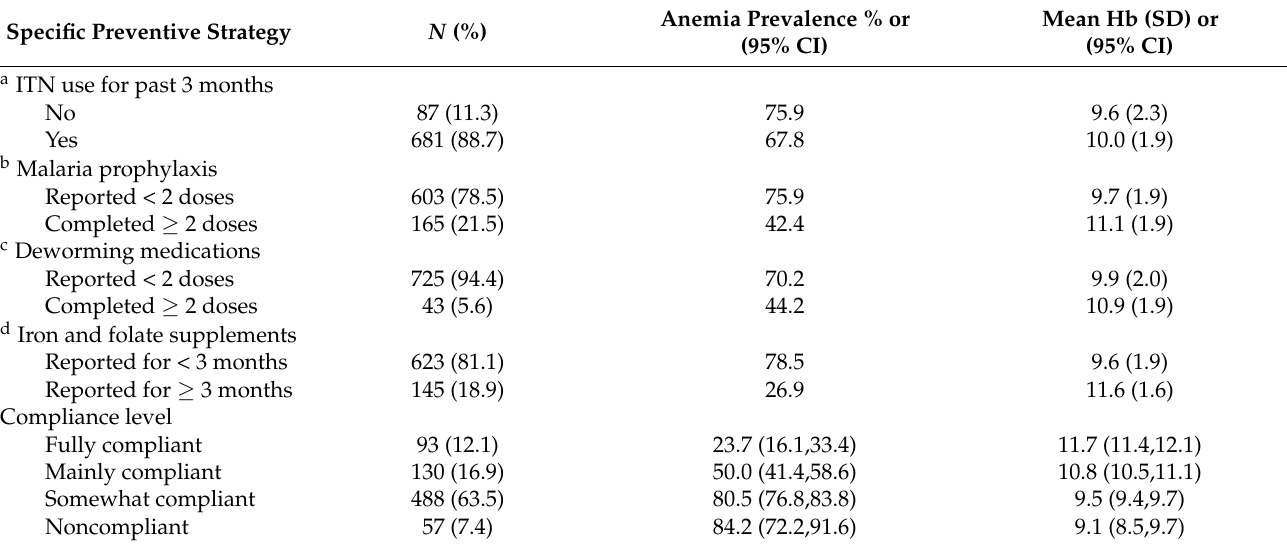
Table 2. Anemia preventive strategies among 768 pregnant women in Mwanza,